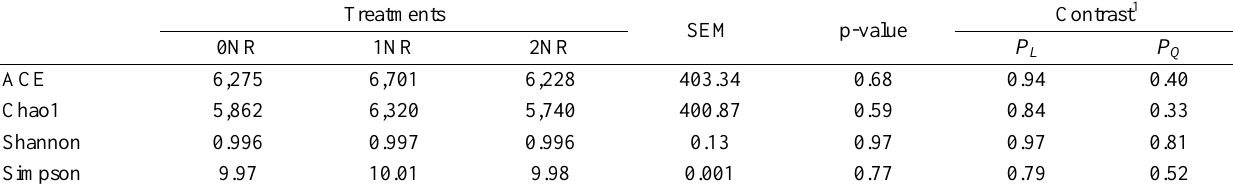
Table 4. Changes in bacterial richness and biodiversity by nitrate